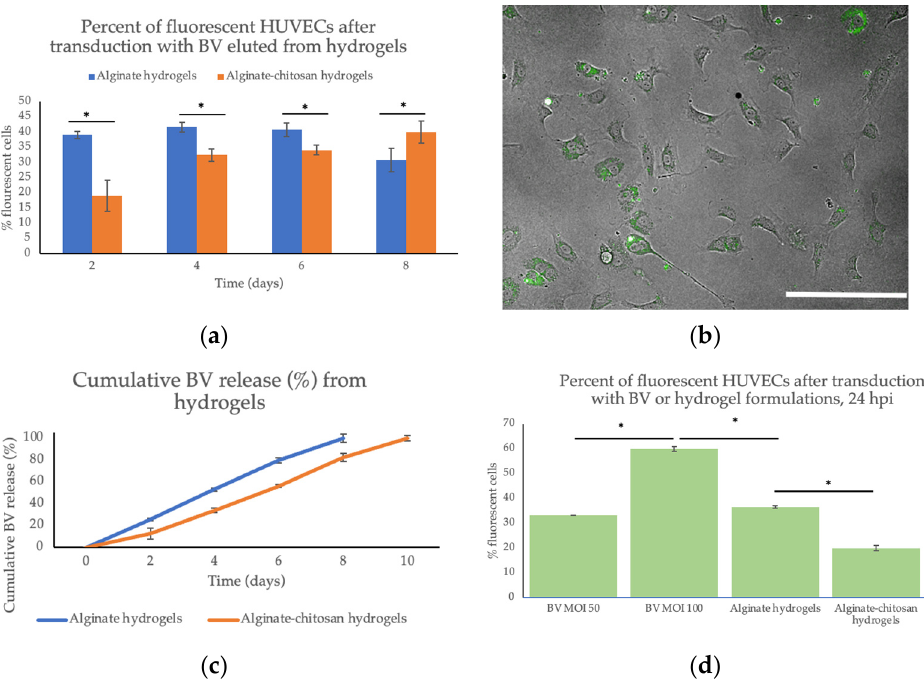
Figure 2. ( a ) Percentage of fluorescent HUVECs after transduction with baculovirus eluted from hydrogels. ( b ) Brightfield image overlaid with a fluorescent image of HUVECs transduced with baculovirus eluted from alginate–chitosan hydrogels on day 3 at 20× magnification, scale bar = 200 μ m. ( c ) Cumulative BV release (%) from alginate and alginate–chitosan hydrogels. ( d ) Percentage of fluorescent HUVECs after transduction with BVs or hydrogel suspension media, 24 hpi. n = 3 per group for each experiment. * Indicates a significance of p < 0.05.